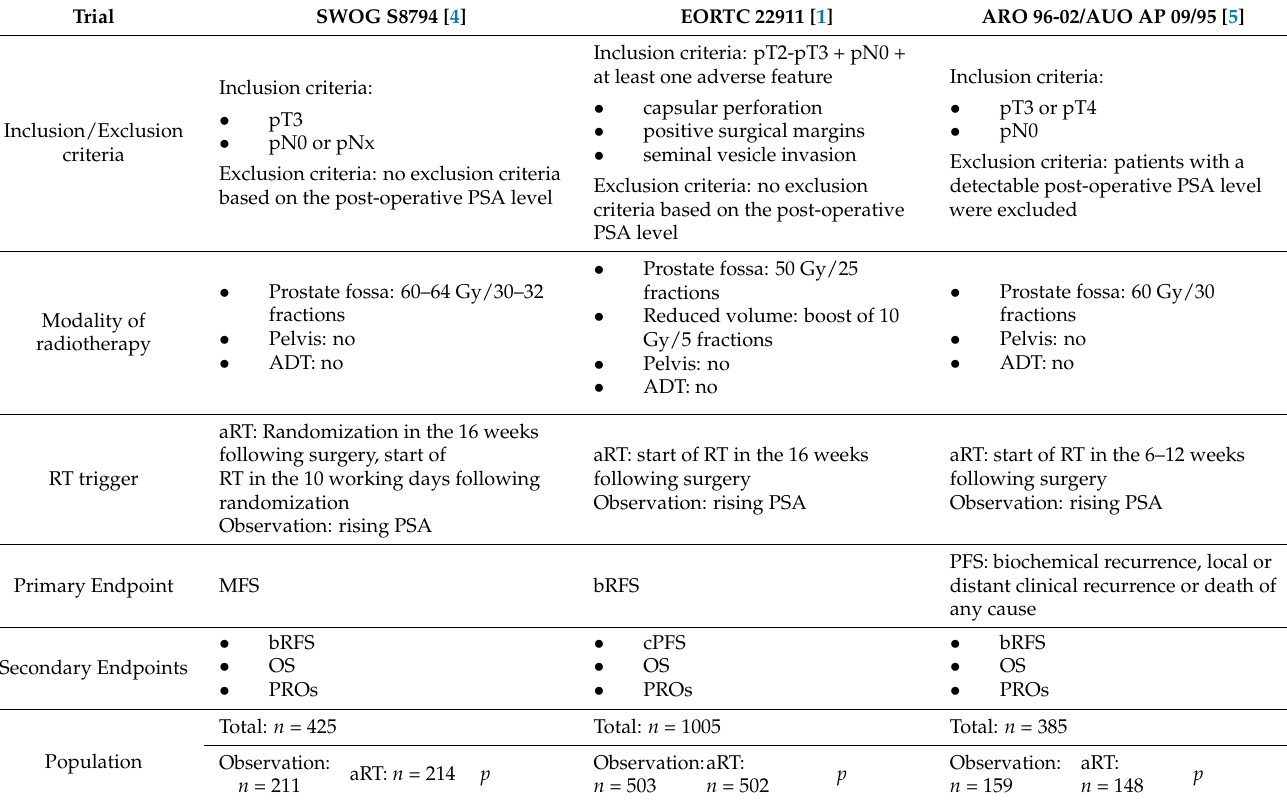
Table 1. Key results from the adjuvant vs. salvage radiotherapy